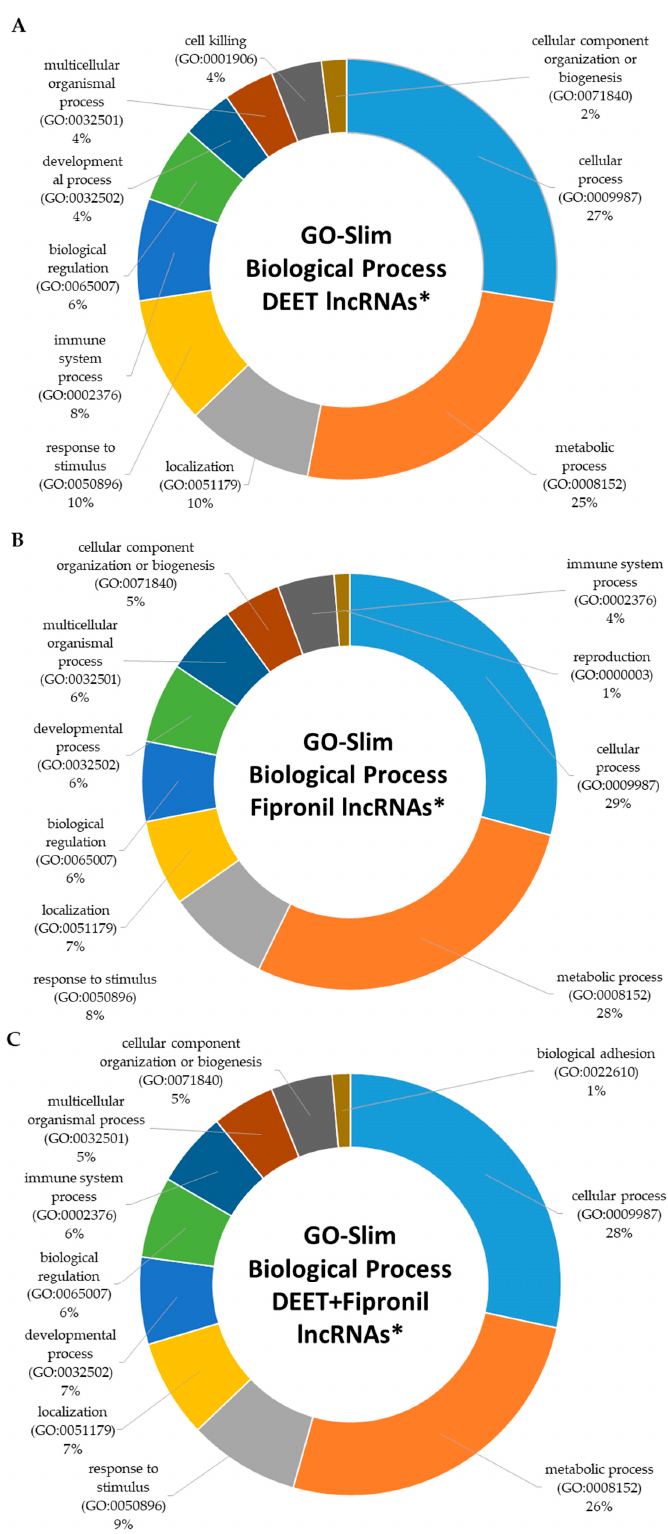
Figure 5. Top 10 biological processes affected by exposure of primary human hepatocytes to ( A ) 100 µ M DEET; ( B ) 10 µ M fipronil; and ( C ) 100 µ M DEET plus 10 µ M fipronil. * Assignments were made using GO-Slim analysis of dysregulated lncRNAs and “associated” protein-coding genes (as determined using the GREAT algorithm as described in methods section). GO = gene ontology assignment number.